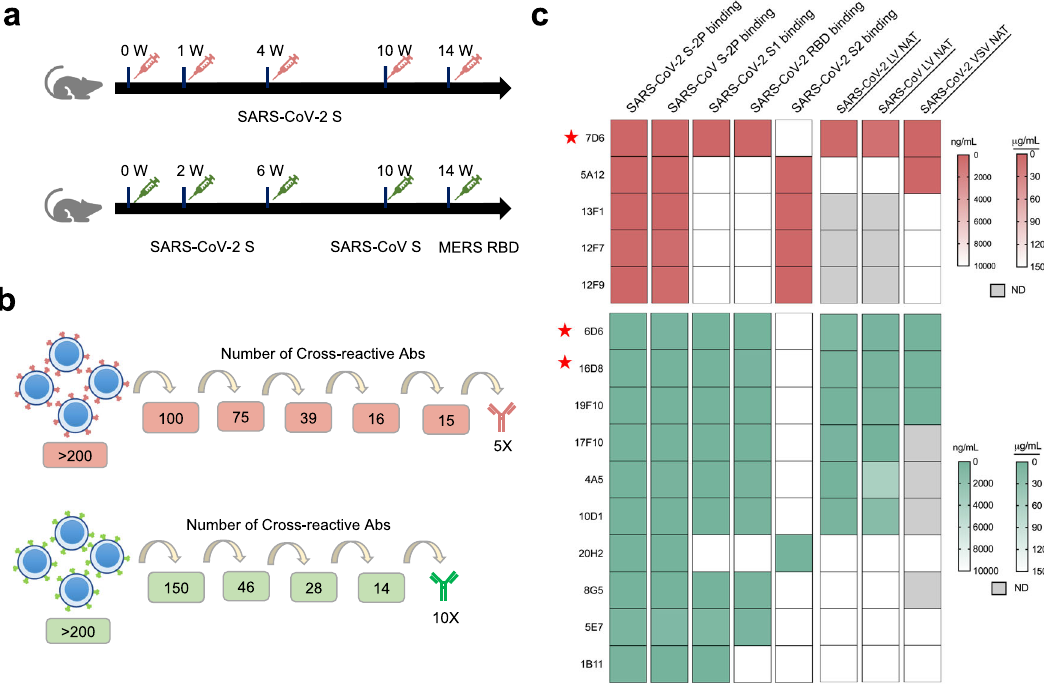
Fig. 1 Screening and characterization of SARS-CoV-2 and SARS-CoV cross-reactive monoclonal antibodies. a The immunization schemes of two different strategies: immunized with the SARS-CoV-2 spike protein alone (upper) or with a combination of the SARS-CoV-2 and SARS-CoV spike proteins and the MERS-CoV RBD (lower). b The number of lead antibodies with cross-activity in each round of screening. c Characterization of 5 and 10 monoclonal antibodies obtained by the fi rst and second immunization strategies, respectively. The neutralizing titers (IC 50 ) based on the vesicular stomatitis virus pseudotyping system (VSV NAT) and the lentiviral virus pseudotyping system (LV NAT) were tested. ND means not detected. Asterisks indicate the top three monoclonal antibodies with excellent cross-neutralizing